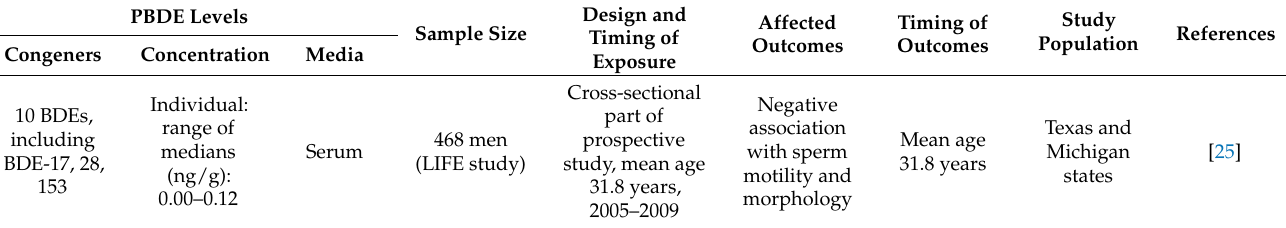
Table 1. Summary of human studies assessing male reproductive toxicity of PBDEs. PBDE